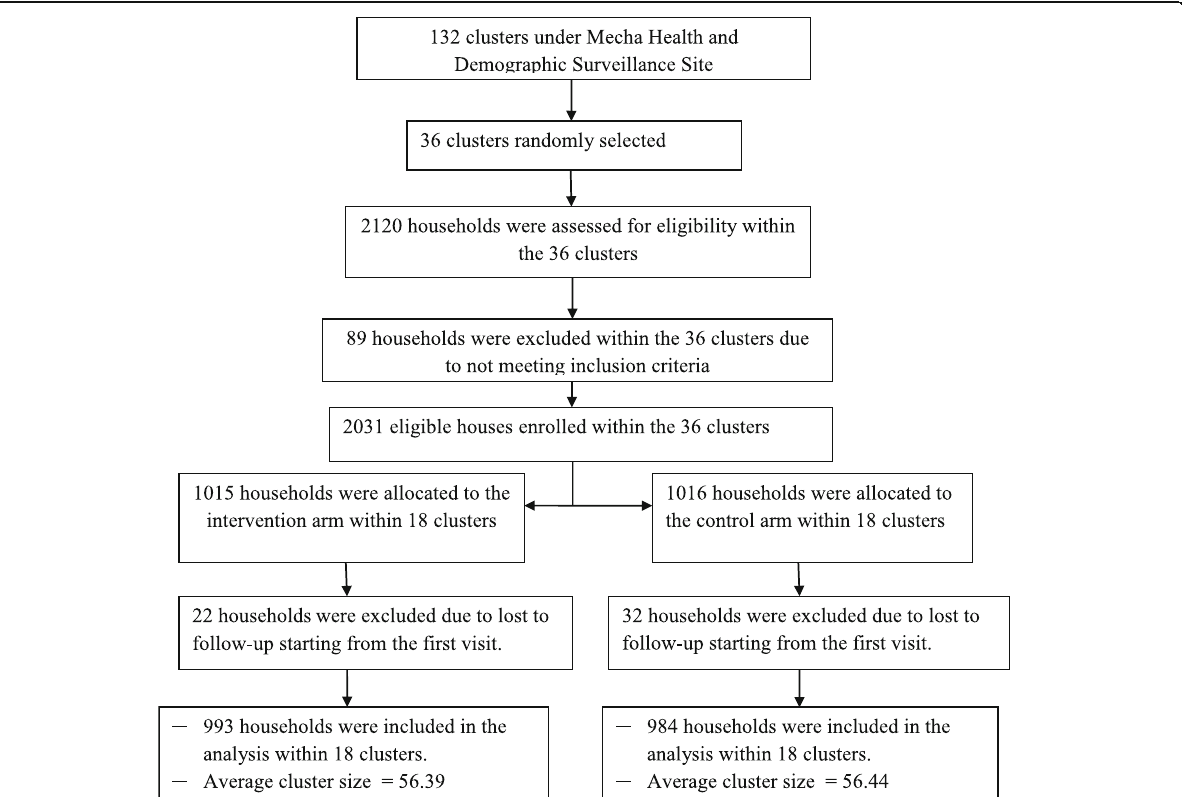
Fig. 2 Flow diagram of the study progress from eligibility assessment to enrollment, follow-up, and analysis to test the effect of biomass-fuelled improved cookstove intervention aimed at reducing the magnitude of household air pollution compared with the continuation of an open burning TCS